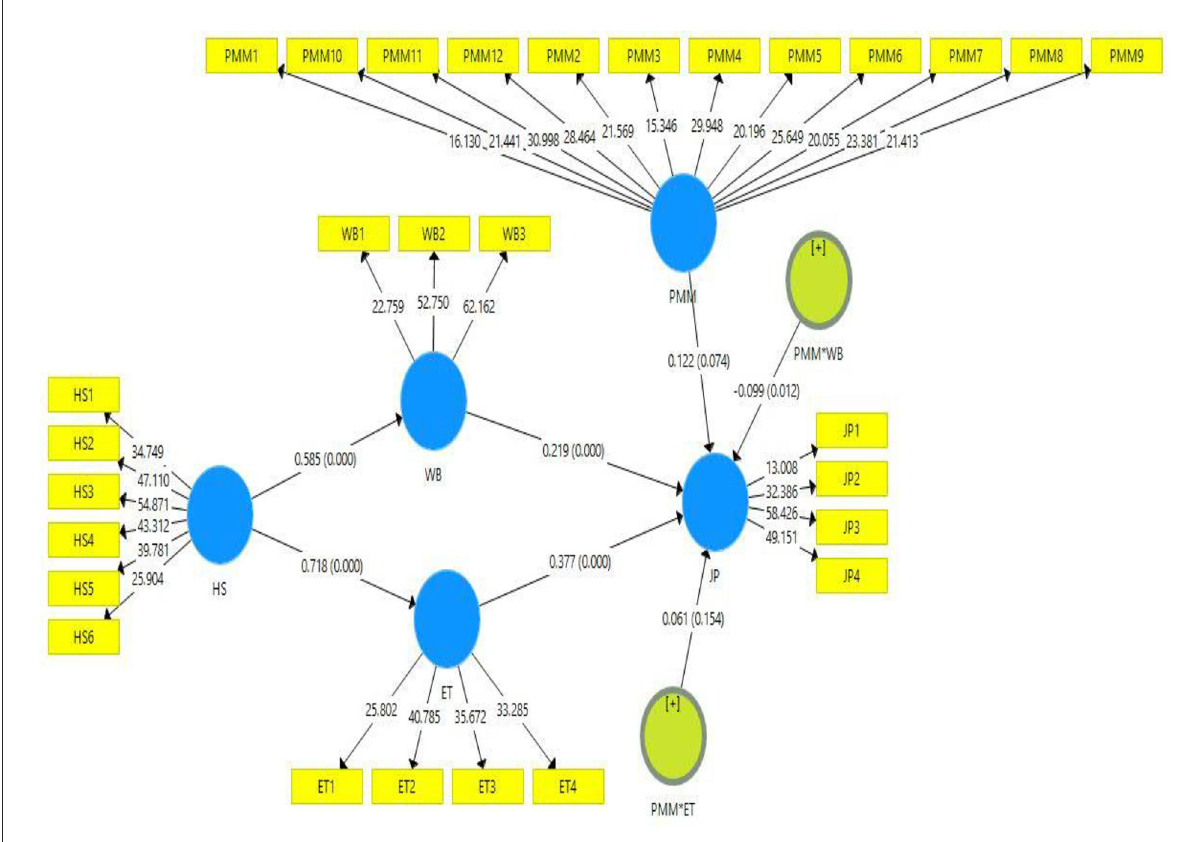
FIGURE3 Bootstrapping estimates.